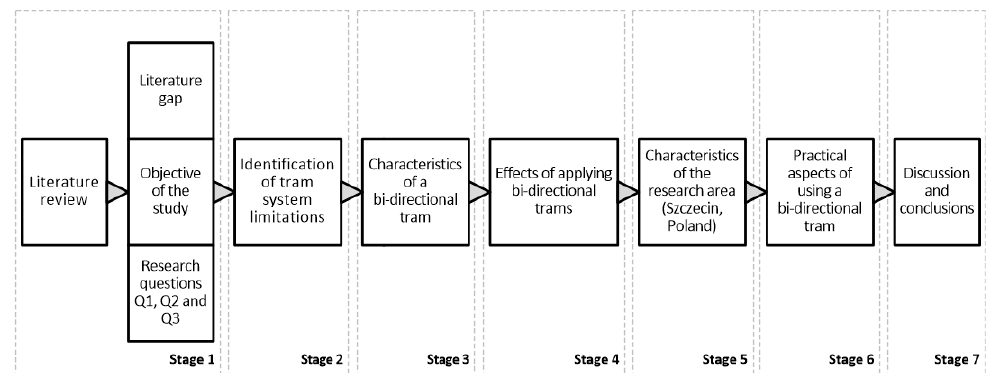
Figure 1. The research process flow diagram.